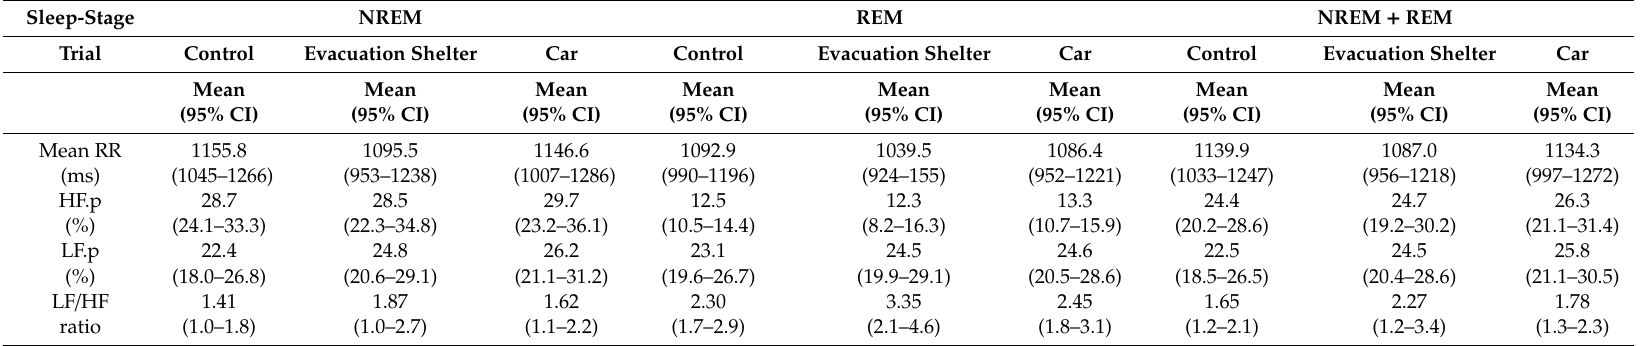
Table 3. Results of heart rate variability during NREM and REM sleep ( n =